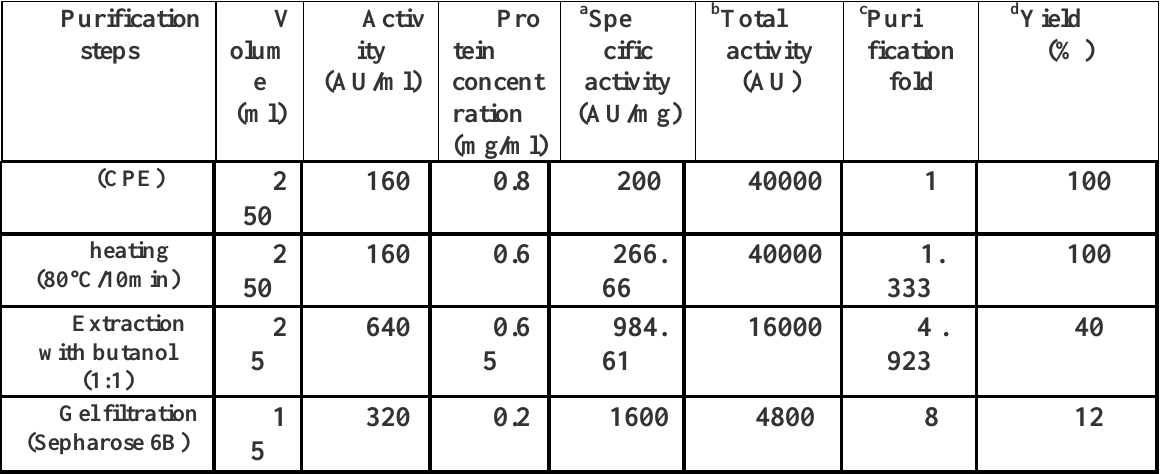
a Specific activity (AU/mg): represents plantaricin activity divided by protein concentration. b Total activity (AU): represents Activity (AU/ml) × Volume (ml). c Purification fold: represents specific activity of purified fraction divided by specific activity of crude extract. d Yield (%): represents (total activity of purified fraction divided by total activity of crude extract) × 100